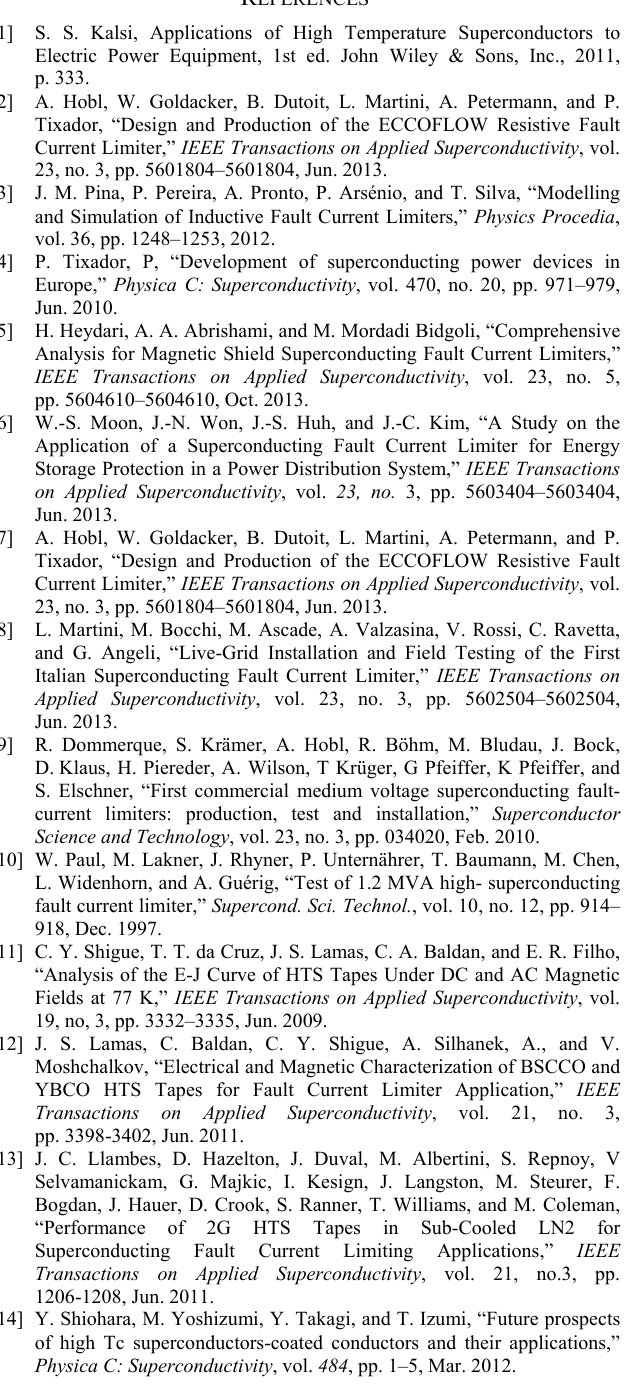
the maximum measured